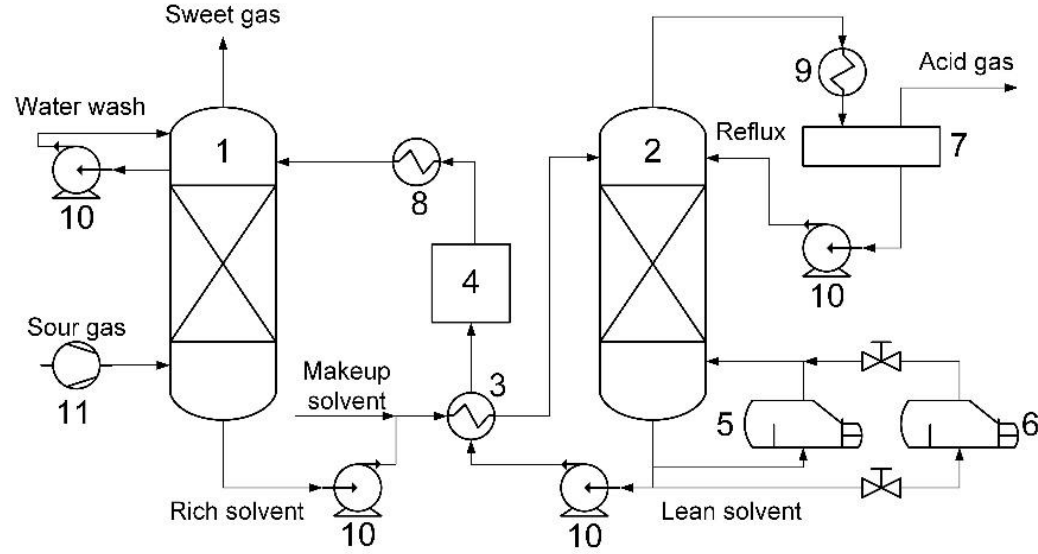
Figure 6. Principle of absorption-based acid gas capture technology: 1—absorber; 2—stripper; 3—rich/lean heat-exchanger; 4—filter; 5—reboiler; 6—solvent reclaiming unit; 7—reflux drum; 8—cooler; 9—condenser; 10—pump; and, 11—compressor.